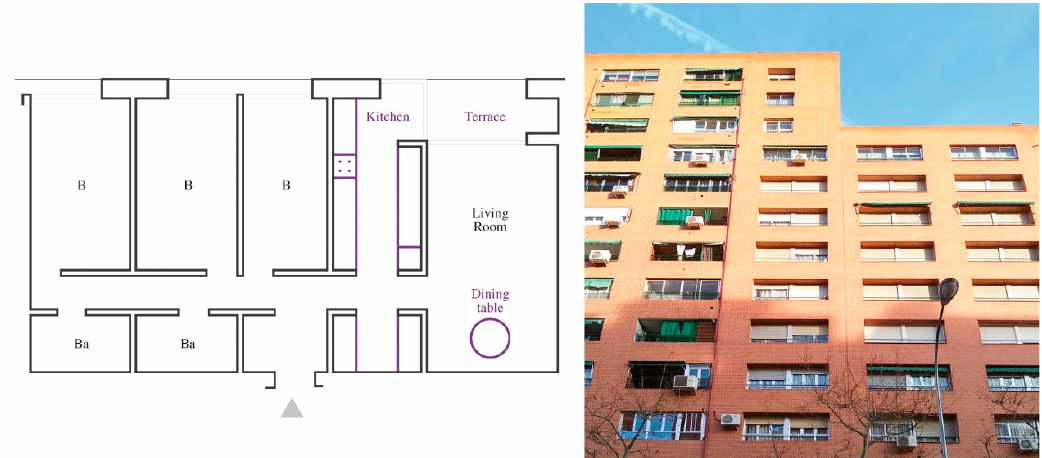
Figure 7. Social housing in Palomeras Sureste. Three bedrooms apartment. Plan redrawn and photo by author.